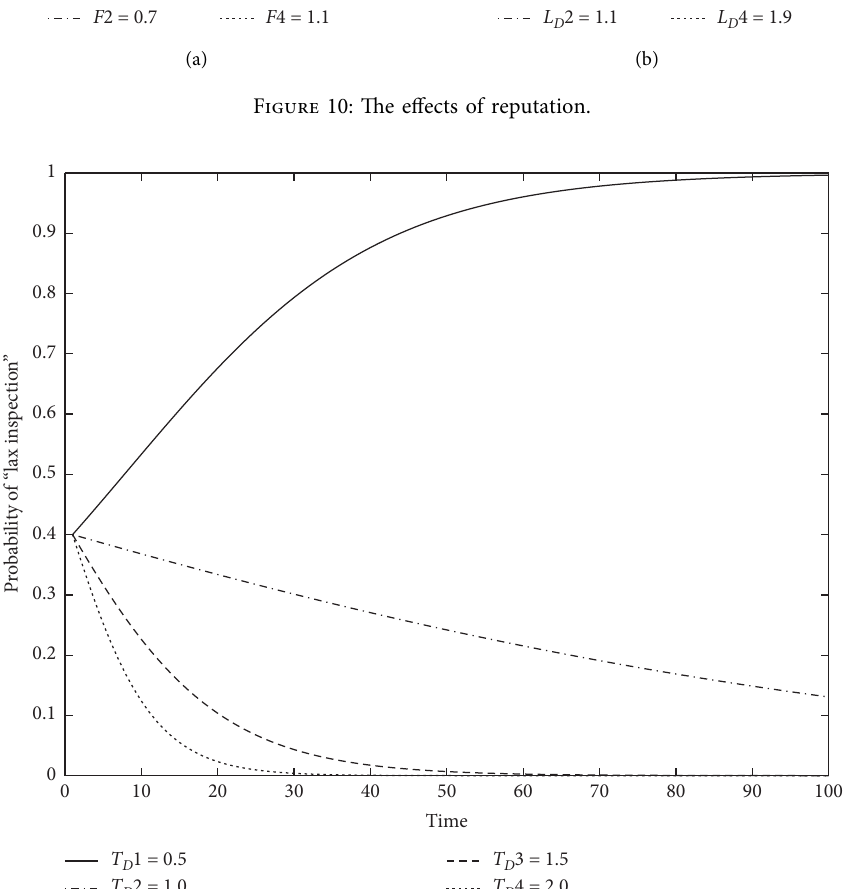
Figure 11: The effects of government